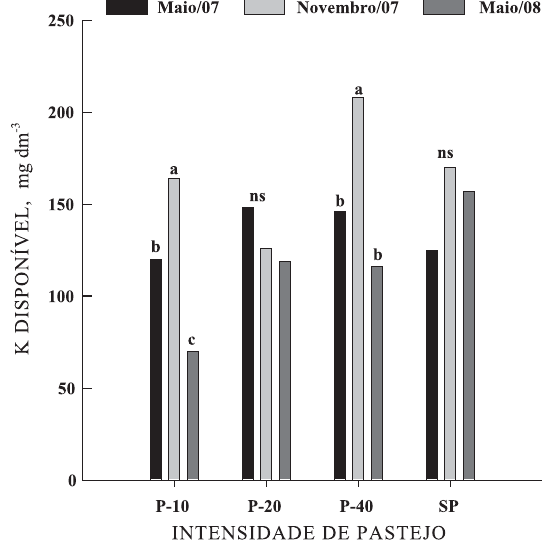
Figura 2. Teores de potássio disponível (Mehlich-1) na camada do solo de 0-20 cm em função de diferentes intensidades de pastejo (10, 20 e 40 cm de altura do pasto - P-10, P-20 e P-40, respectivamente) e sem pastejo (SP), nos meses de maio e novembro de 2007 e maio de 2008. Médias com a mesma letra, em cada